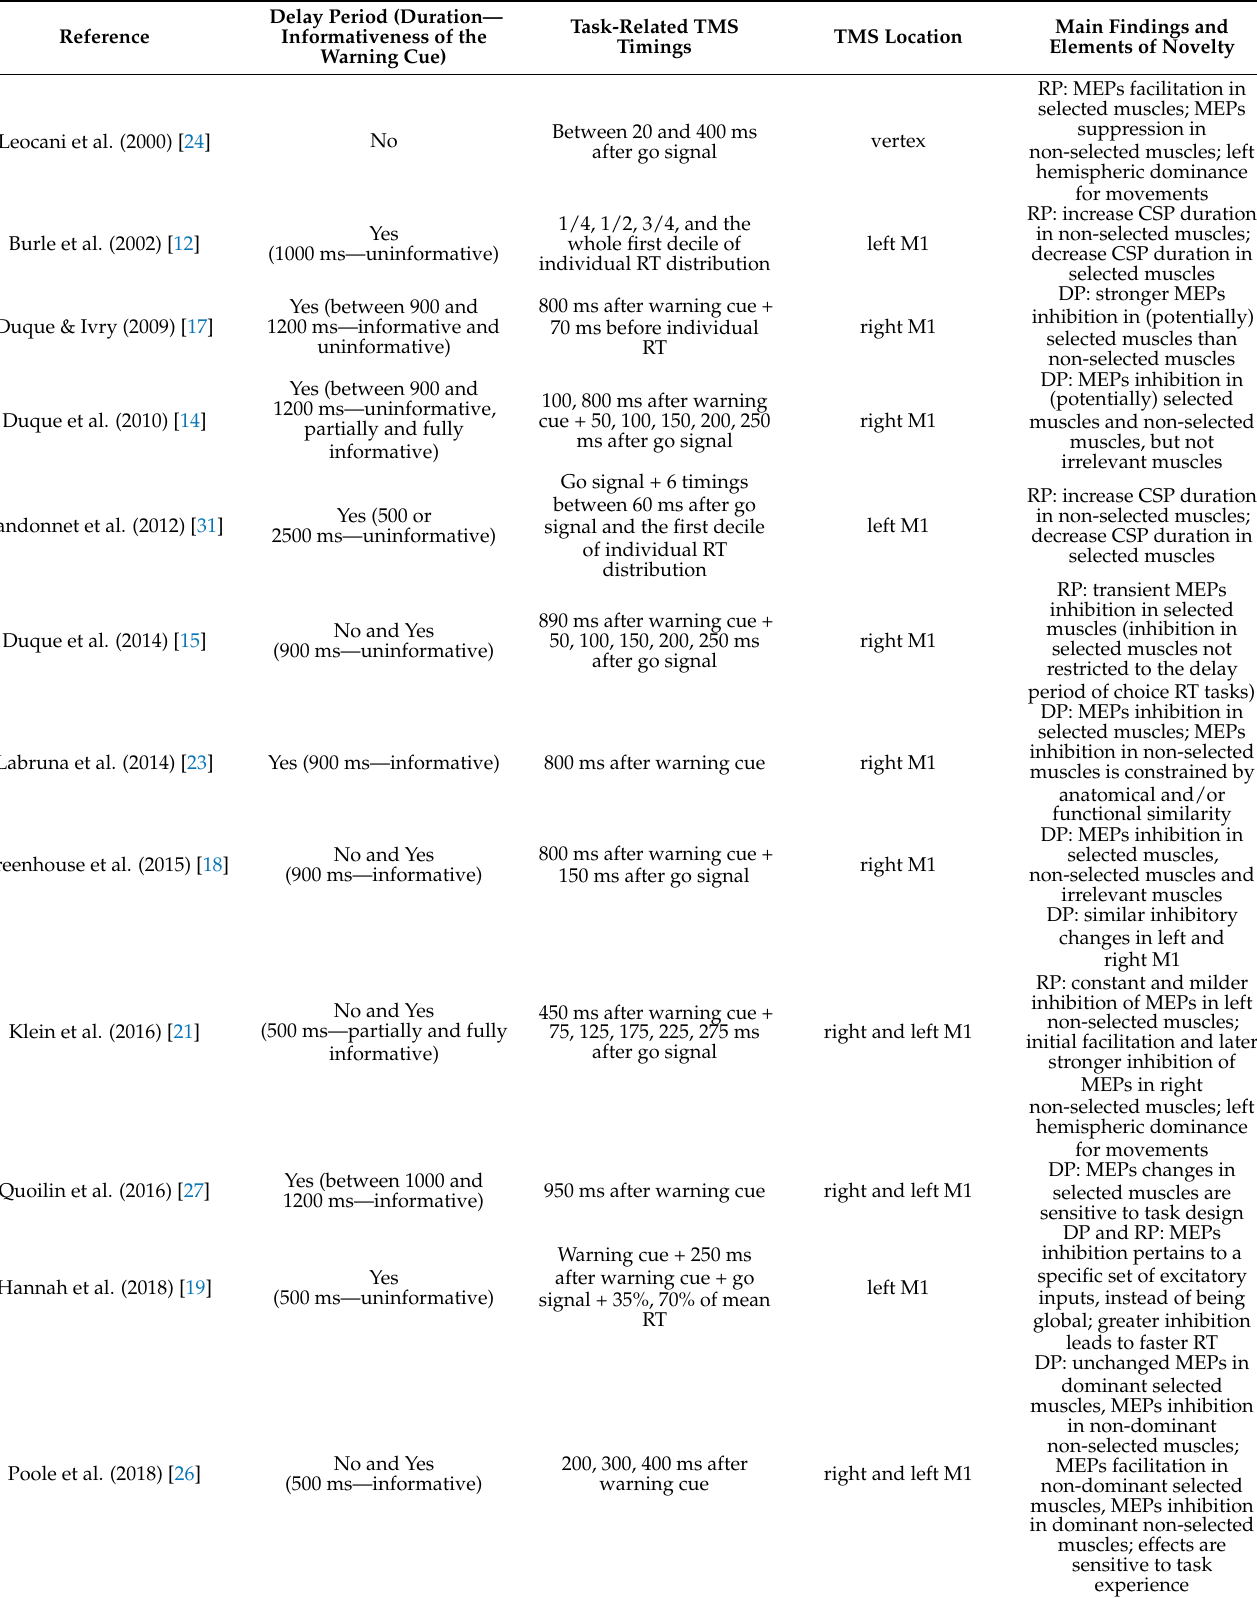
Table 1. Characteristics of key studies using spTMS in the context of choice RT